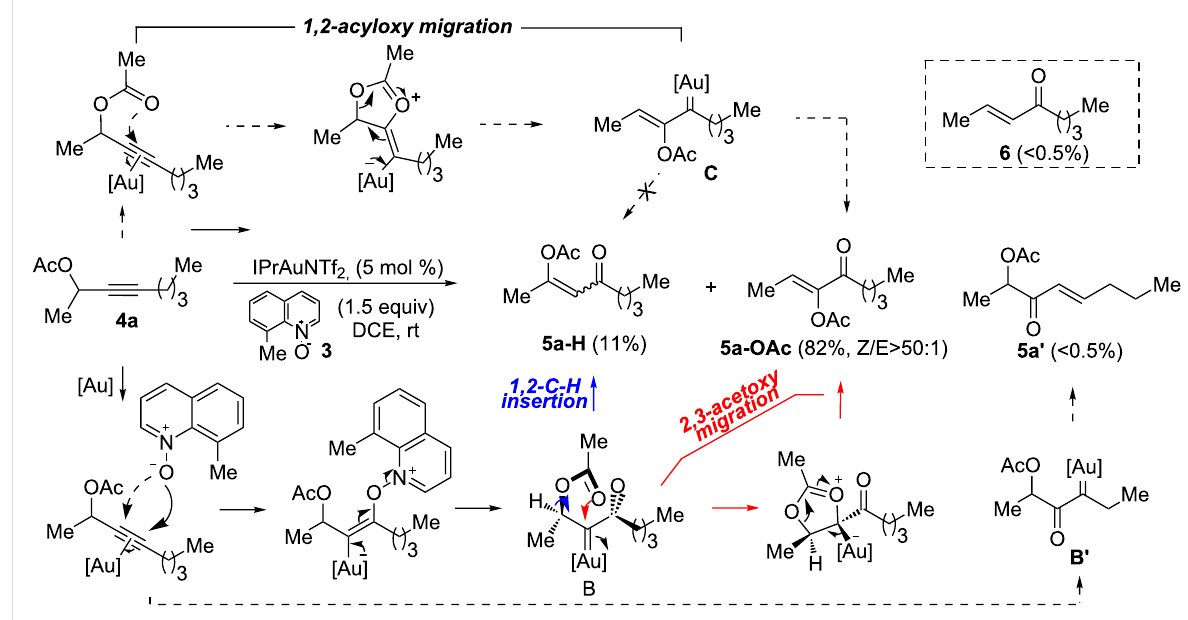
Scheme 3: Gold-catalyzed oxidation of the propargylic acetate 4a and the mechanistic rationale.